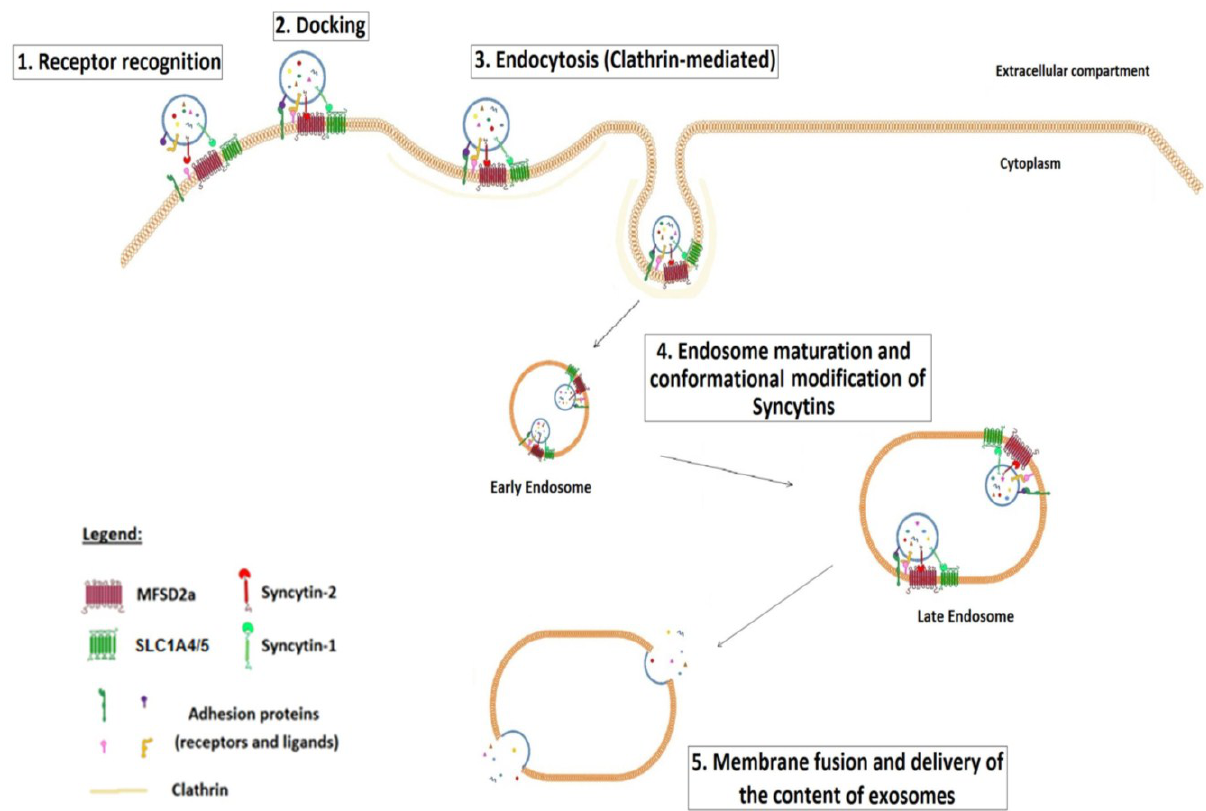
Figure 3. Exosome-associated Syncytin-1 and -2 allow specific entry of exosomes